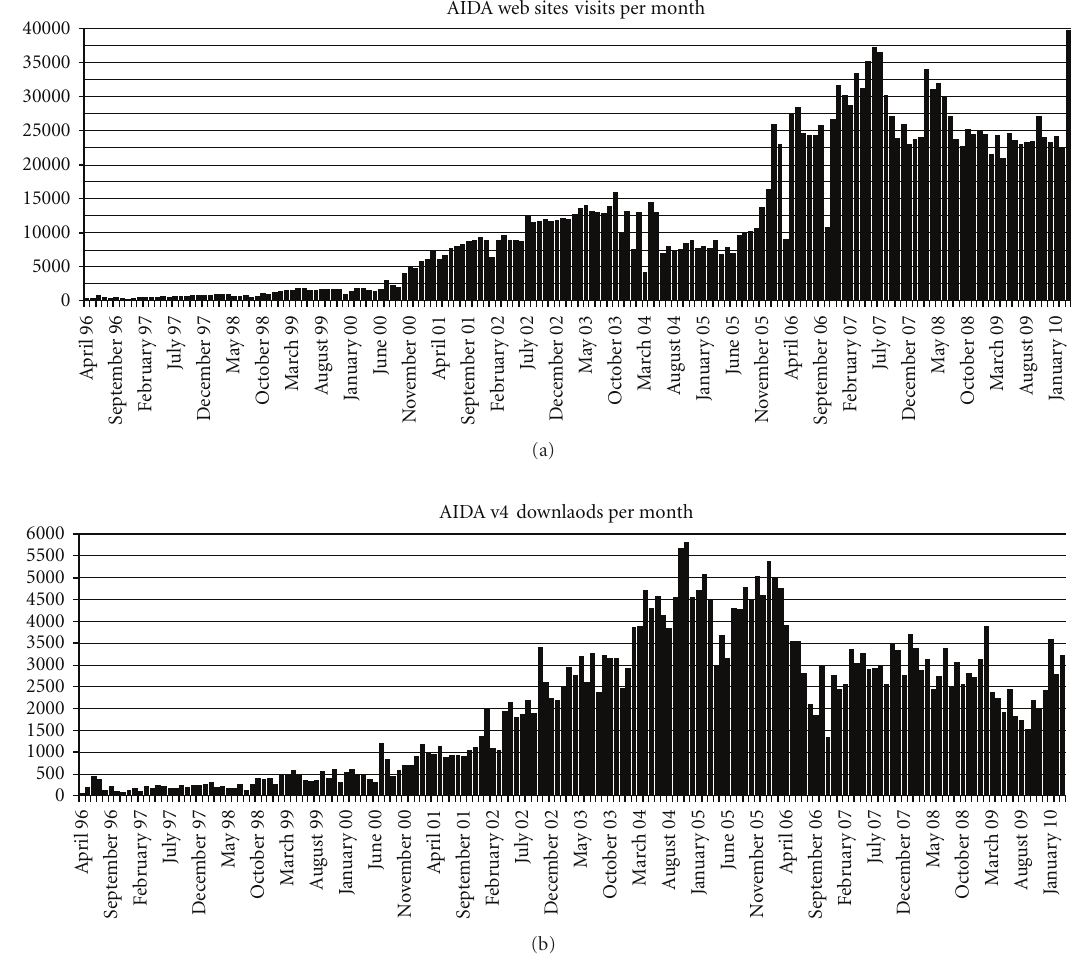
Figure 1: Number of (a) visits and (b) downloads per month at the two AIDA websites (http://www.2aida.org/ and http://www.2aida.net/) since March/April 1996 when AIDA first went live on the Internet—up to March/April 2010—just before the web launch of AIDA v4.3b. Despite the age of the software, there continues to be considerable interest in the program with a large number of site visitors and